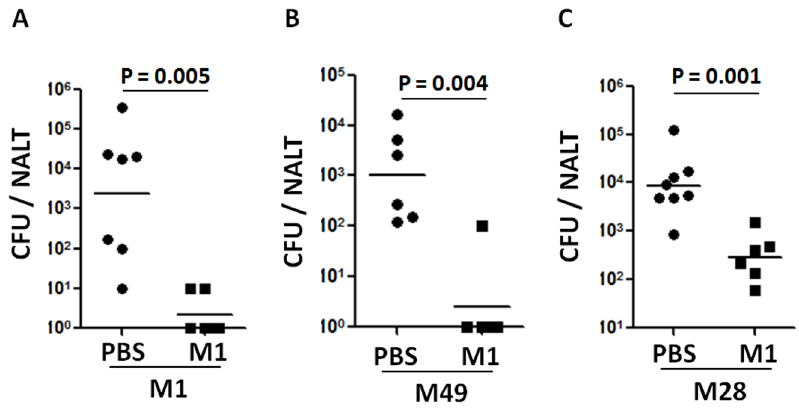
Figure 1. Immunization (i.n.) with live GAS strain M1 provided cross-serotype protection. Mice were i.n. immunized three times with live M1 strain (0.5 2 1.0 6 10 8 /mouse). 10 days after the last immunization mice were challenged with a sublethal dose of GAS serotypes M1 ( A ), M49 ( B ), or M28 ( C ) (Material and Methods). NALTs were taken 24 hr after challenge and homogenized for CFU counting. Data are geometric means of two independent